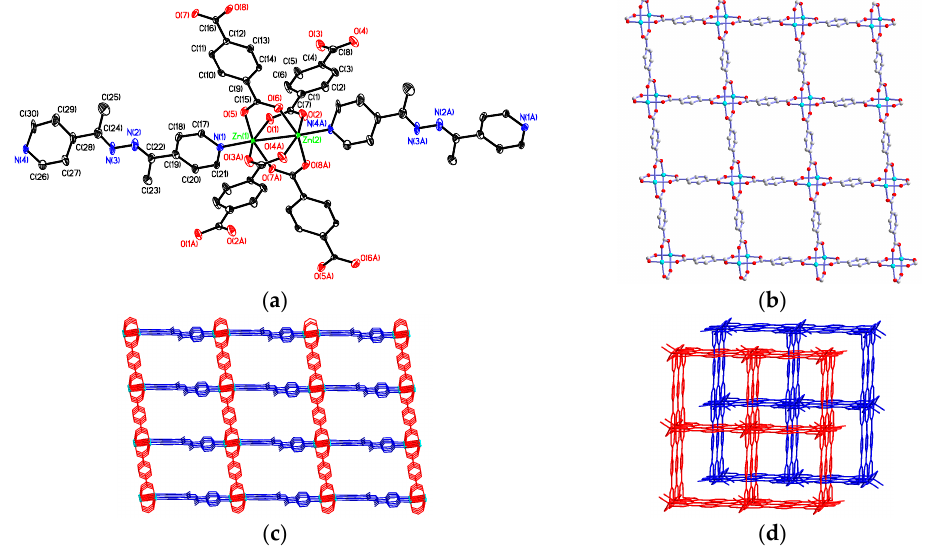
interpenetrating 3D supramolecular architecture of 1 . 3D supramolecular architecture of 1 .